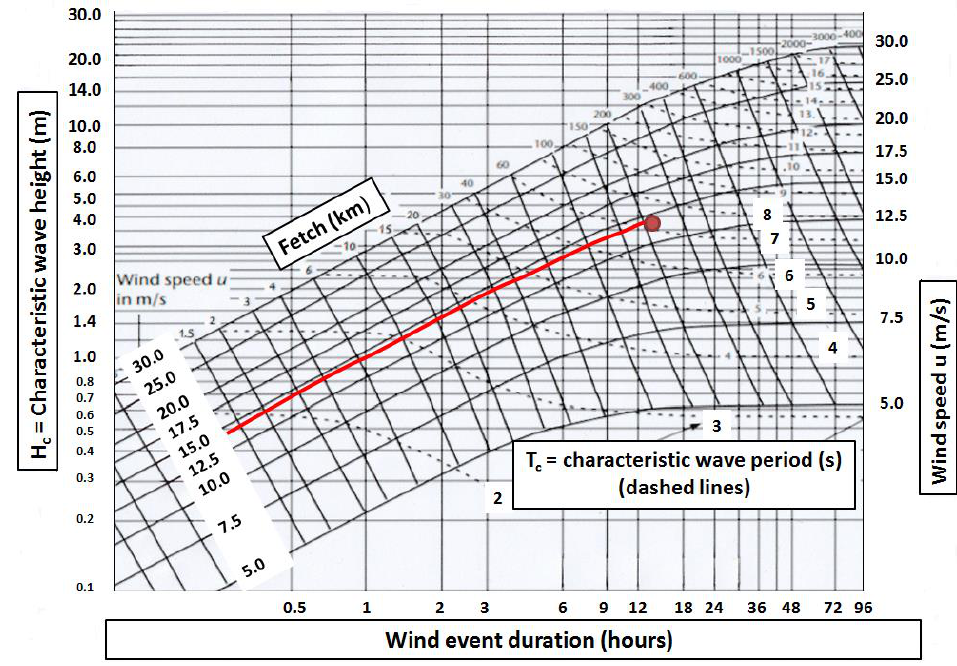
Figure 14. Wave growth nomogram modified by Gröen and Dorrestein [28]. The red line illustrates the development of wave motion considering a constant anemometric event (14.4 m s −1 ) lasting for 14 h.